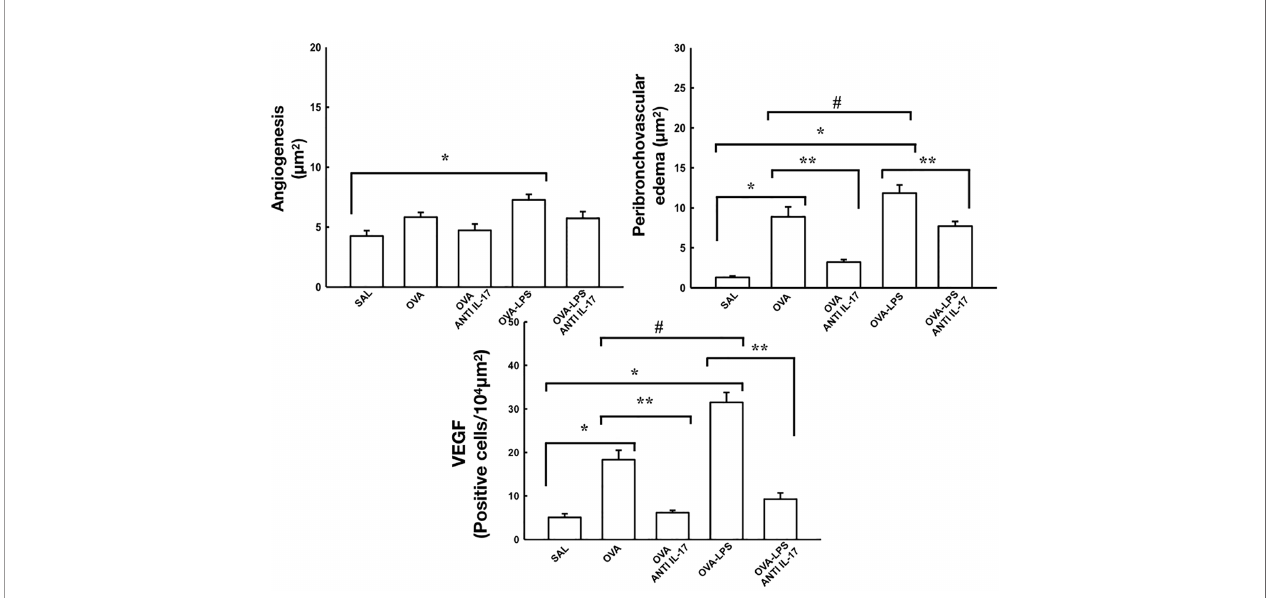
FIGURE 6 | Effects of anti-IL-17 treatment on angiogenesis, peribronchovascular edema, and vascular endothelial growth factor (VEGF). The values represent the mean ± standard error (SE) of the angiogenesis, peribronchovascular edema, and vascular endothelial growth factor (VEGF) for all experimental groups. The differences were considered signi fi cant when p<0.05. *p<0.05 vs. SAL group; **p<0.05 vs. OVA and OVA – LPS groups. # p<0.05 vs. OVA